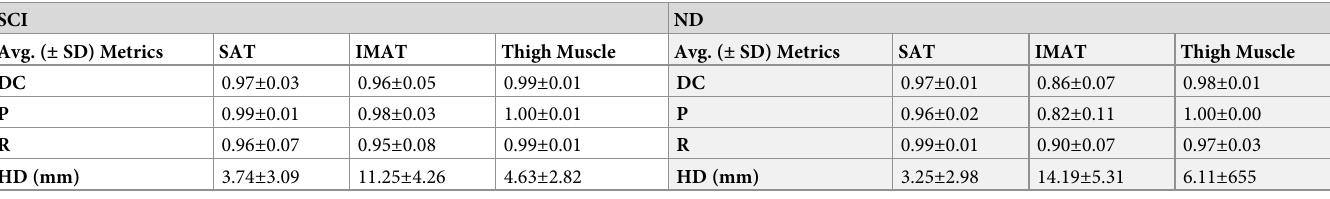
The average ( ± SD) values of accuracy measures (Dice’s coefficient (DC), Recall (R), and Precision (P) of the proposed fat segmentation approach for SCI (N = 16) and ND (N = 14)